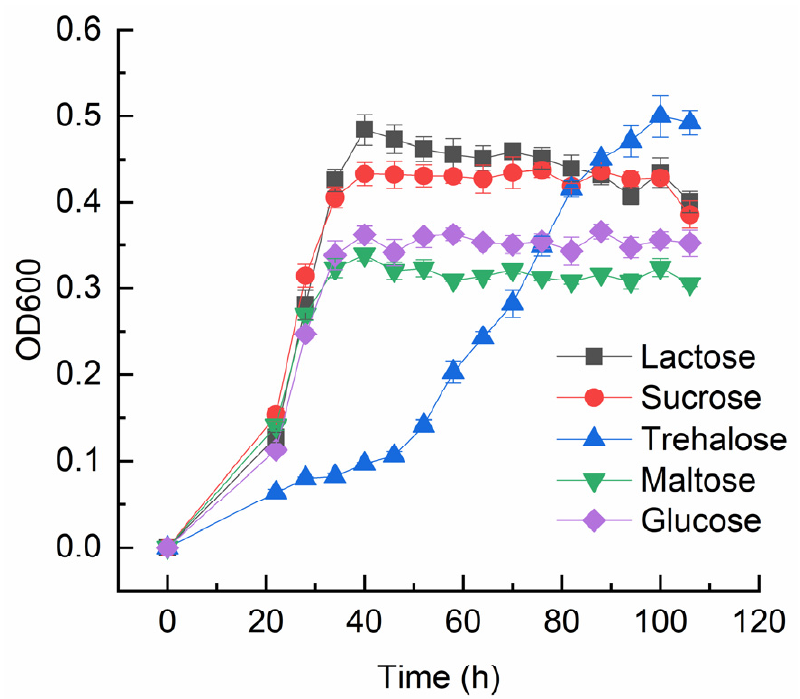
Figure 1. Growth analysis of M. phyllosphaerae LW106 strains. M. phyllosphaerae LW106 cells were grown in a 1/4 TSB medium containing 3 g/L of lactose, sucrose, trehalose, maltose, and glucose, respectively. Experiments were performed in triplicate, and the average values are shown.